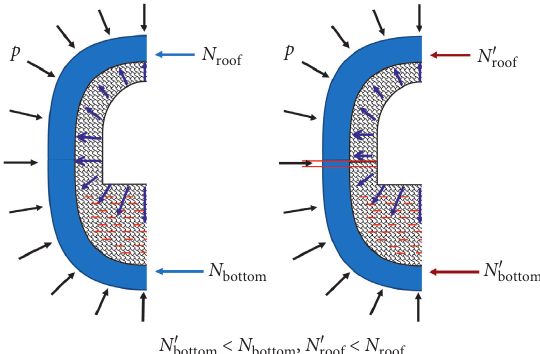
Figure 10: Schematic diagram of double-row anchor cables re- inforcement support